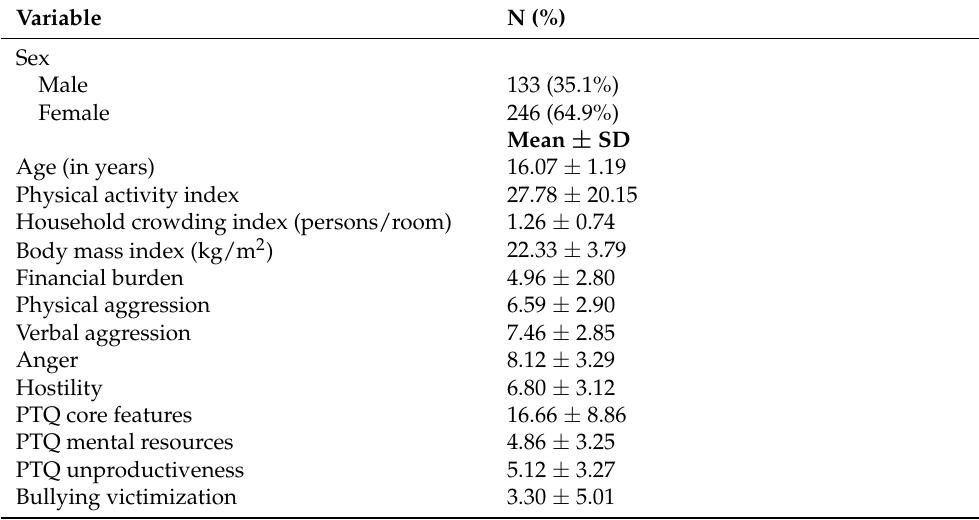
Table 1. Sociodemographic and other characteristics of the participants ( N =